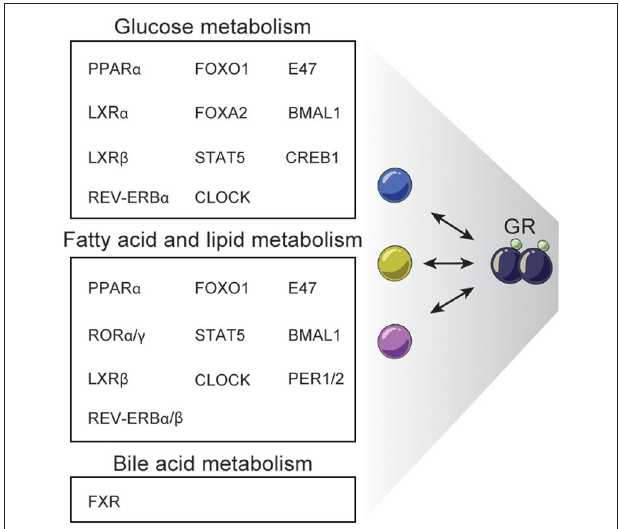
FIGURE 4 | Examples of TFs interacting with GR regulating hepatic metabolism. GR interacts with different TFs to regulate specific processes in hepatic glucose, fatty acid, lipid, and bile acid